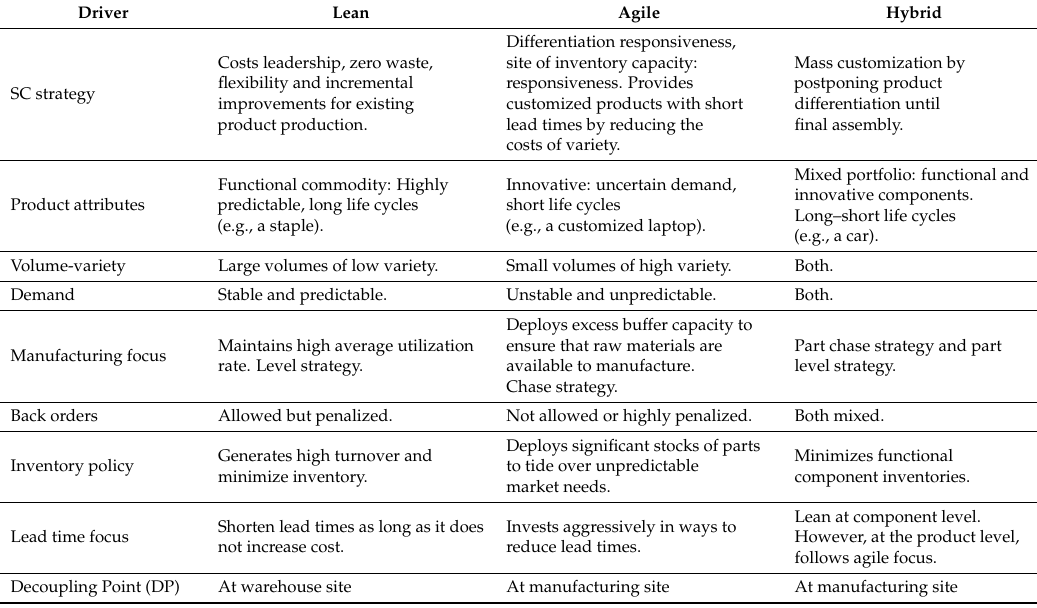
Table 1. Attributes of lean, agile, and hybrid manufacturing supply chain (SC)